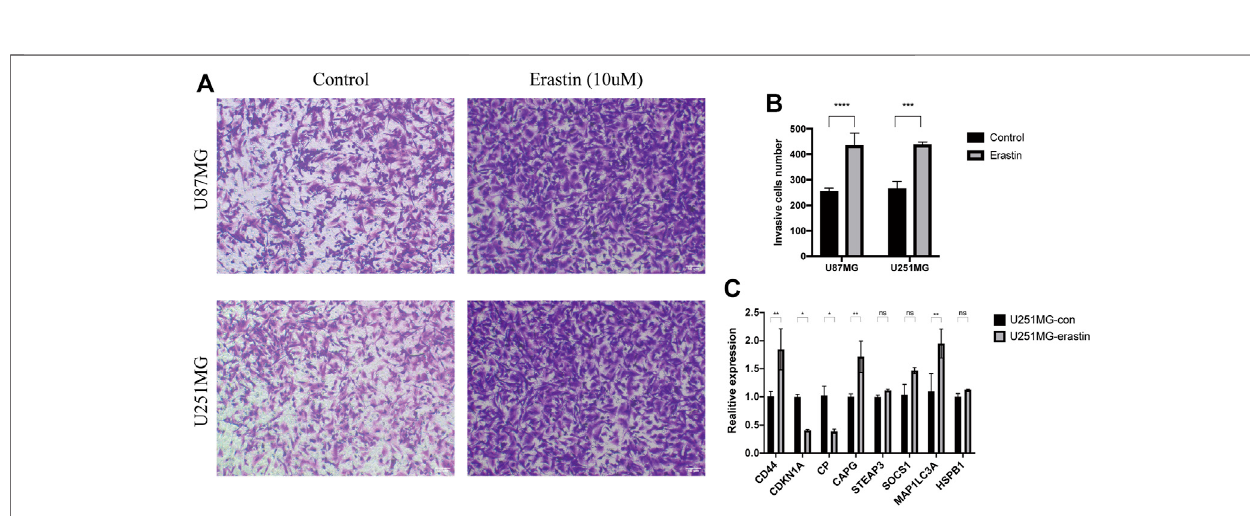
FIGURE 5 | Validation of protein expression by immunohistochemistry of the key genes from the Human Protein Atlas (HPA) database.